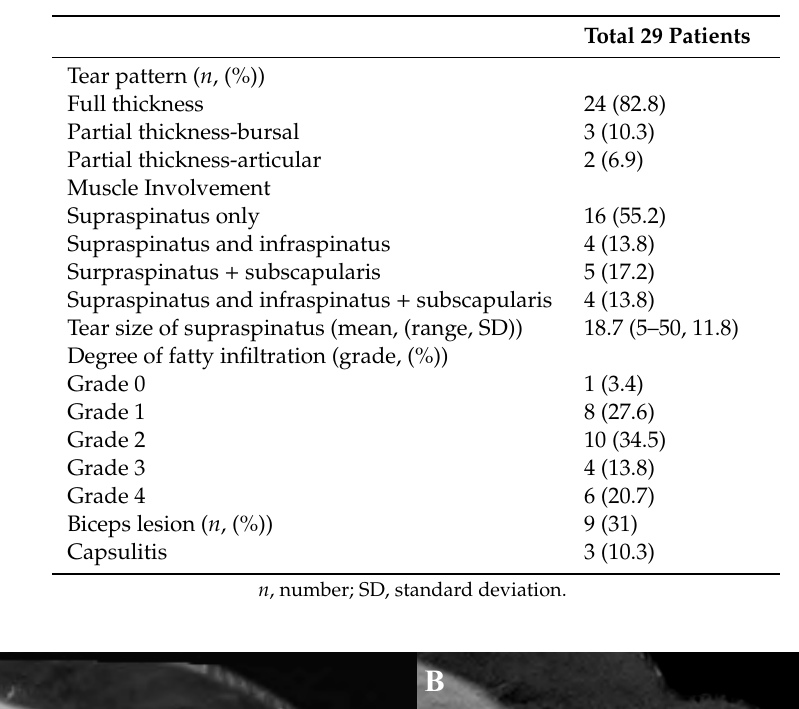
Table 3. Radiographic assessment.